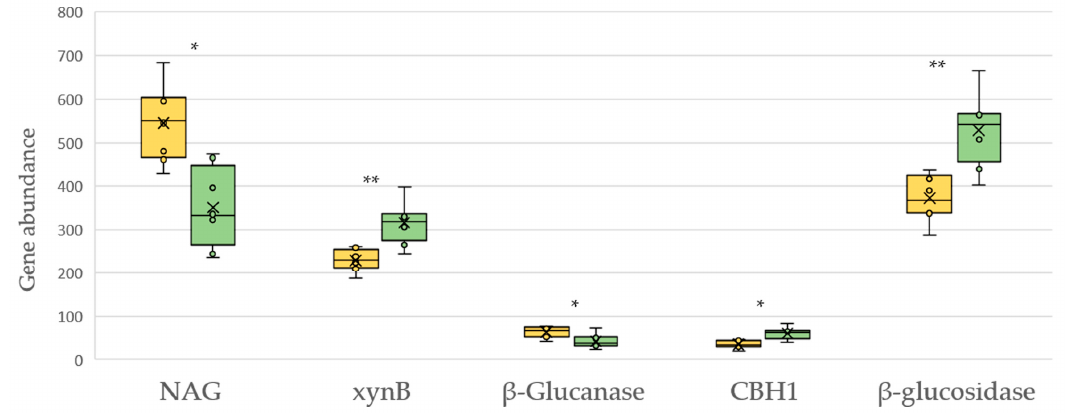
Figure 6. KEGG molecular functions of genes encoding carbon hydrolases in soils under conven-